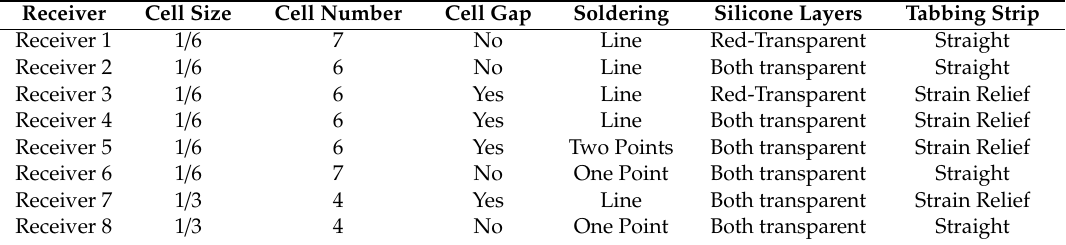
Table 1. Characteristics of the eight small